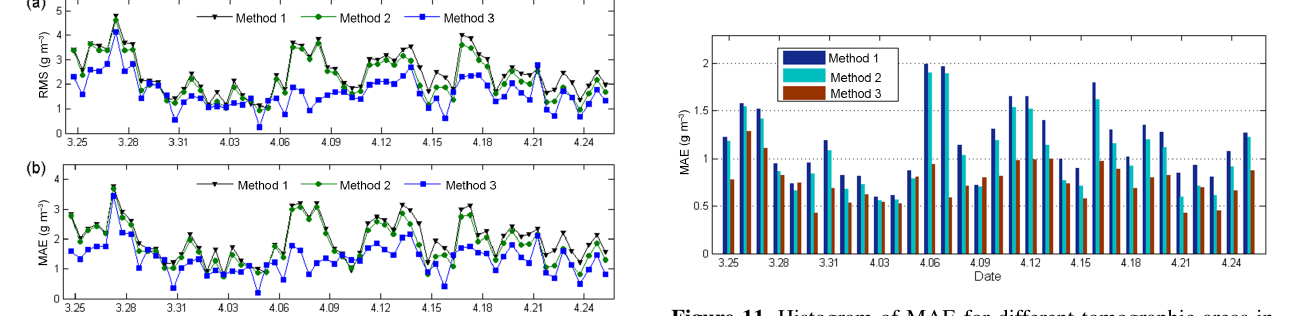
Figure 11. Histogram of MAE for different tomographic areas in the experiment.